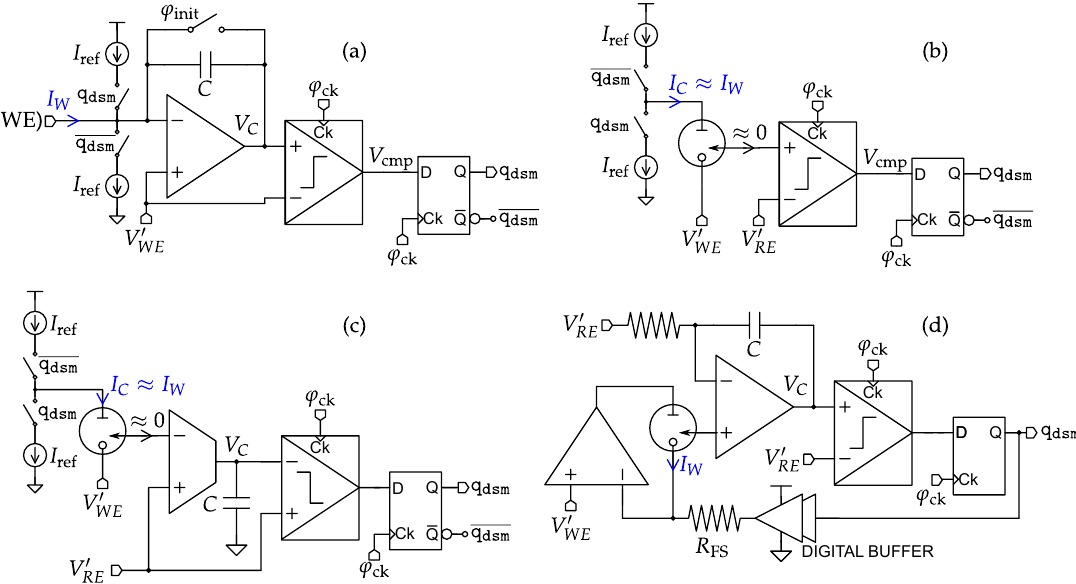
Figure 18. Potentiostats with embedded ∆Σ modulation (I-to- ∆Σ M type). ( a ) based on transimpedance amplifier; ( b ) sensor-in-the-loop approach, first-order modulator; ( c , d ) sensor-in-the-loop approach, second-order